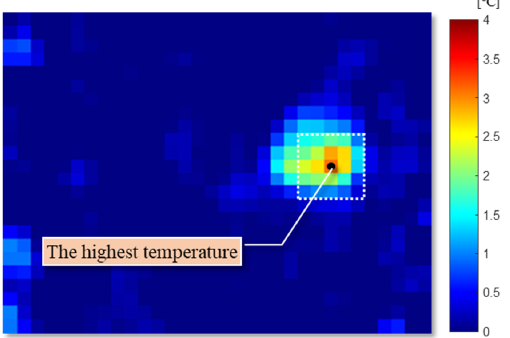
Figure 5. The human detection in the infrared data.